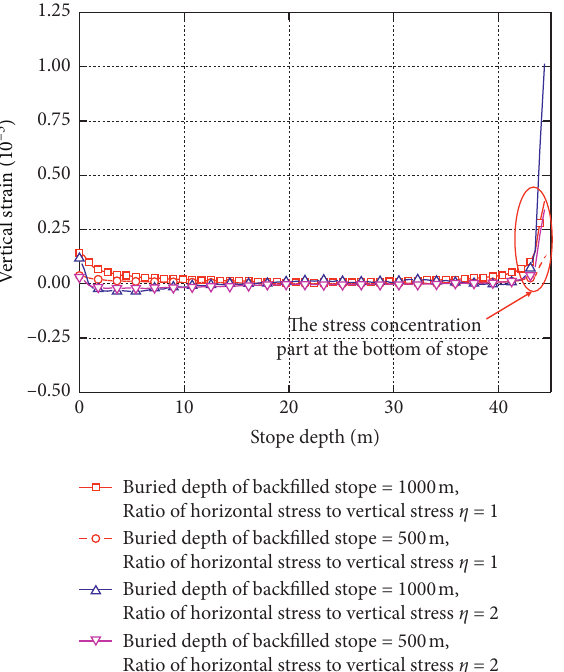
Buried depth of backfilled stope = 1000m, Ratio of horizontal stress to vertical stress η = 1 Buried depth of backfilled stope = 500m, Ratio of horizontal stress to vertical stress η = 1 Buried depth of backfilled stope = 1000m, Ratio of horizontal stress to vertical stress η = 2 Buried depth of backfilled stope = 500m, Ratio of horizontal stress to vertical stress η = Figure 12: Variation of vertical strain of surrounding rock mass in stope area within stope